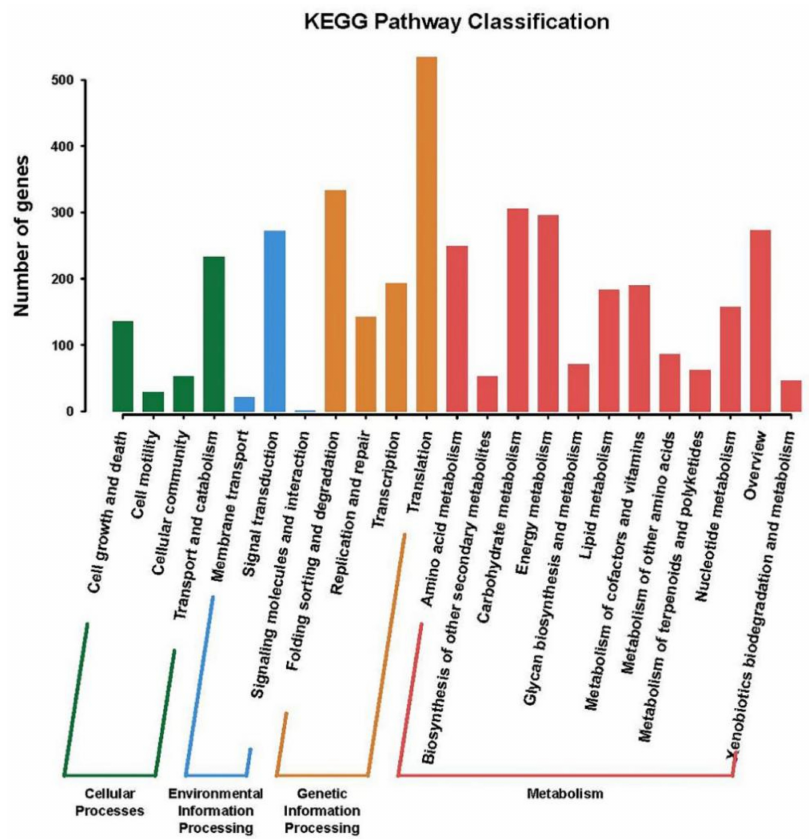
Figure 6. Gene function classification based on the KEGG annotation for the predicted